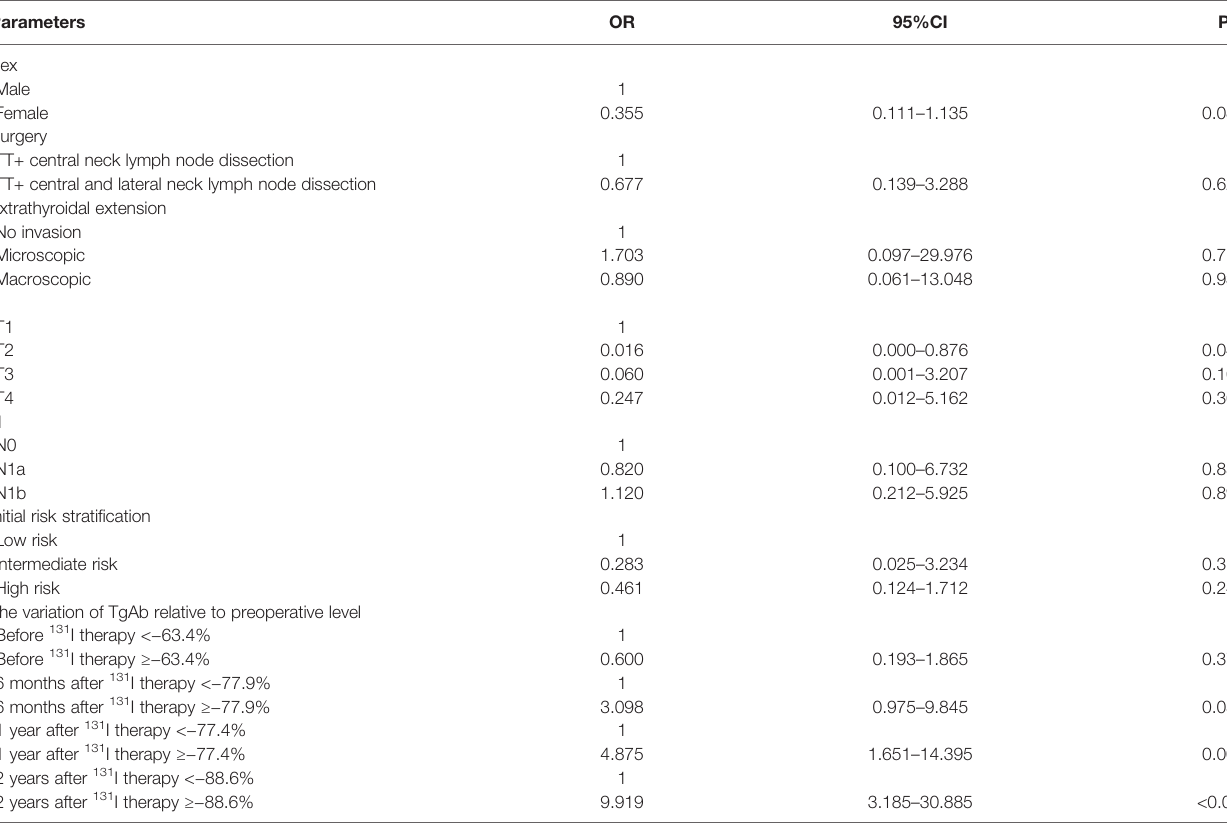
TABLE 6 | Multivariate analysis of predictors of a tumour-free clinical outcome. Parameters